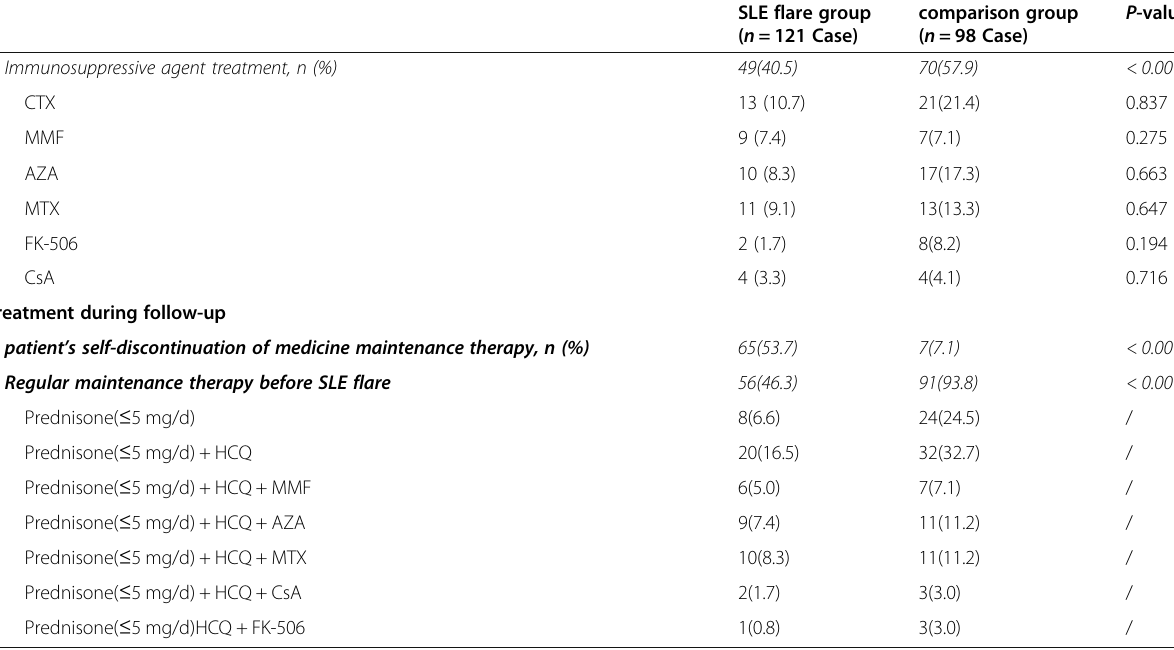
Table 1 Clinical characteristics and treatment in patients with SLE flare or sustained remission of SLE (Continued)